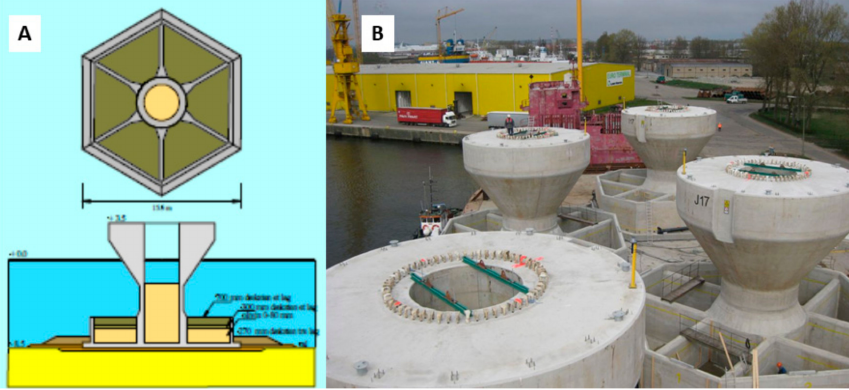
Figure 3. ( A ) Gravity base structure (GBS) at Nysted (Denmark). ( B ) GBS ready for transportation “Rodsand 2”